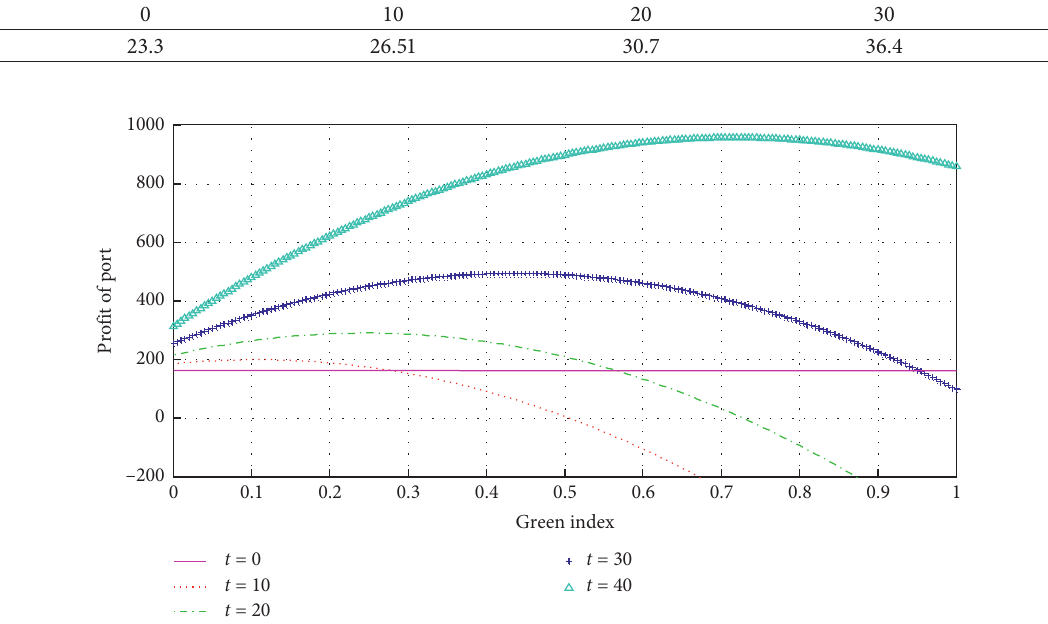
Figure 3: Port profits under different levels of the green index.